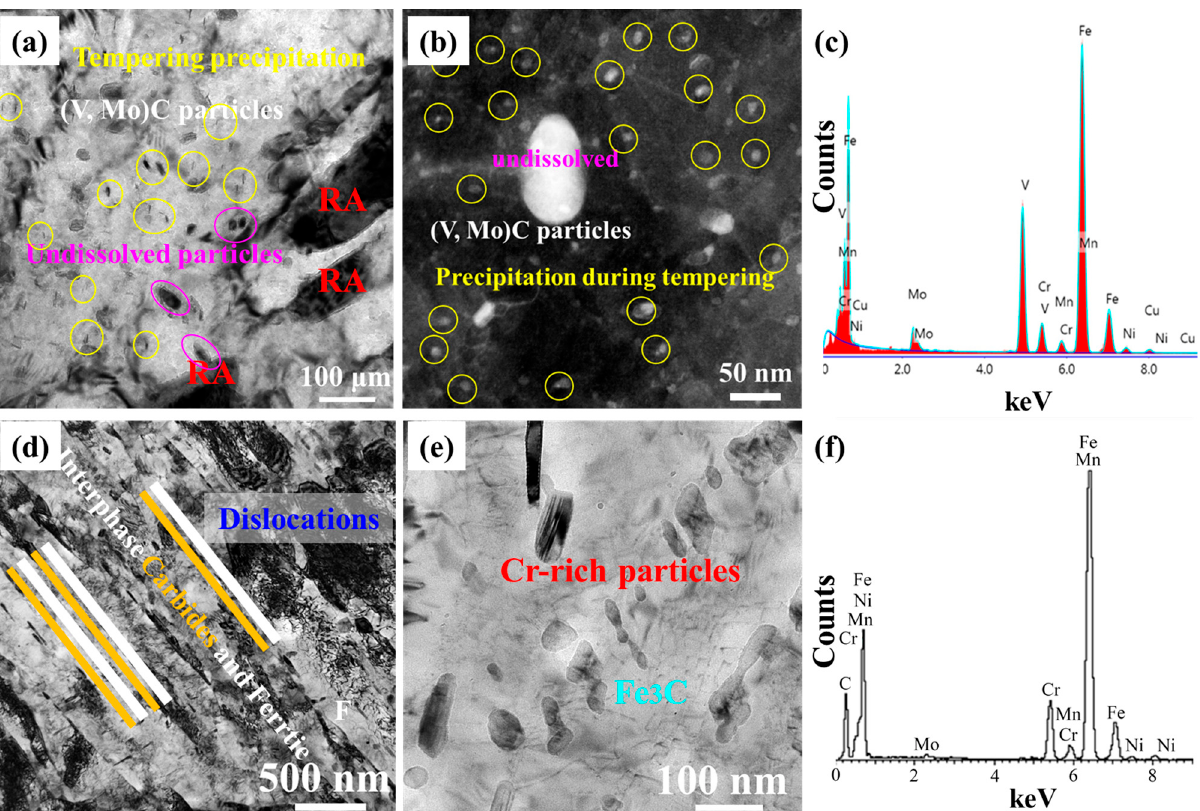
Figure 9. TEM images: ( a ) Bright filed image showing the precipitation particles and RA of 0.12C-3.13Mn steel; ( b ) STEM result showing precipitation particles and ( c ) TEM-EDS of particles; ( d ) Bright filed image showing the structure of martensitic lath and carbides; ( e ) Fe 3 C particles with different morphologies; ( f ) TEM-EDS of particles.